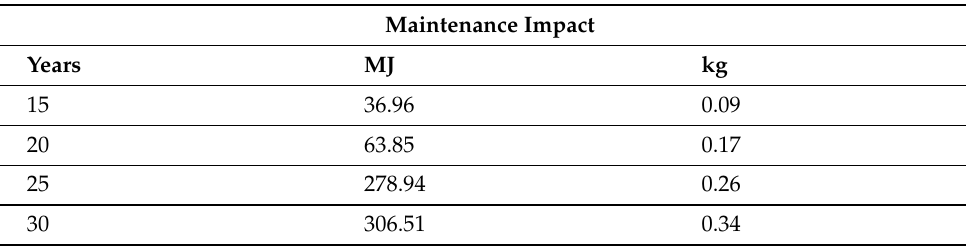
Table 4. Total impact of energy and waste caused by the maintenance of one system according to four different application